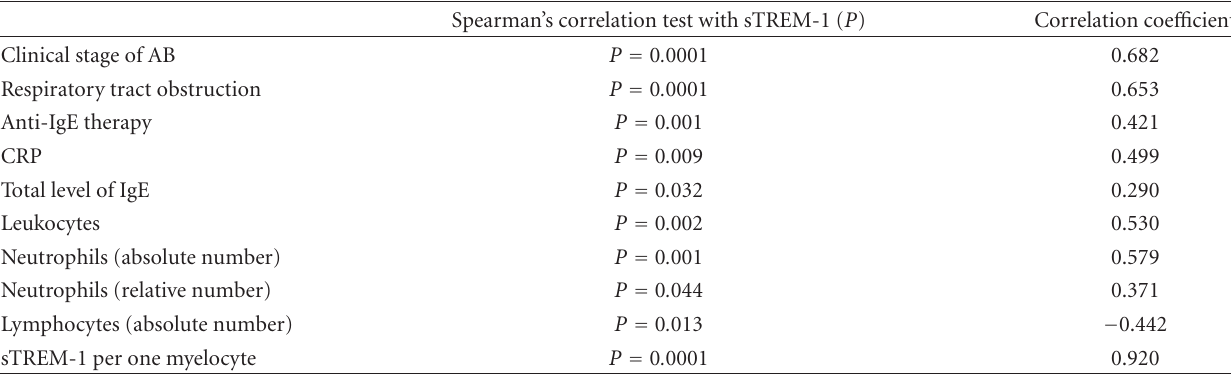
Table 5: Correlations of plasma levels of sTREM-1 with investigated